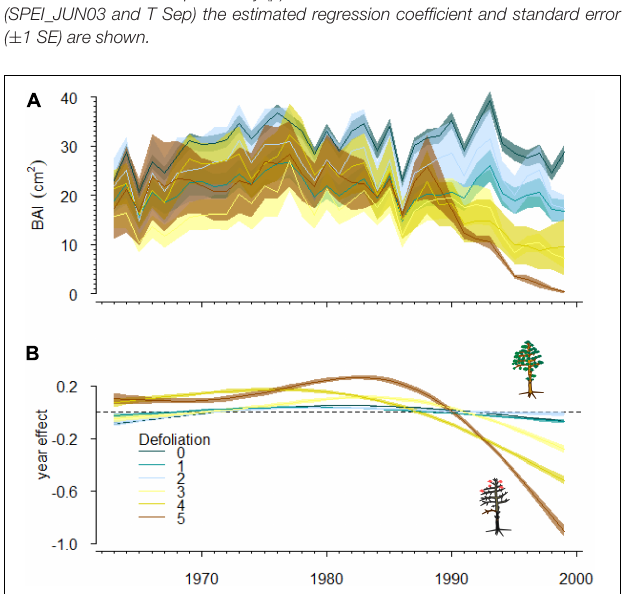
FIGURE 4 | Observed growth trends for trees with different defoliation degree (A) and the effect of year on basal area increment (BAI) (B) . The effect of year on BAI was dependent on defoliation according to the generalized additive model selected ( Table 3 ). Different colors are used to represent the effect of year on BAI at different defoliation classes (0 to 5, from low to complete defoliation; see the tree sketches). Blue and brown colors differenciate non-declining (defoliation degree 0–2) from declining trees (3–5). Values close to zero indicate no influence of year on BAI, larger values indicate stronger effects. Shaded areas represent standard errors for the mean and the effects in (A,B)